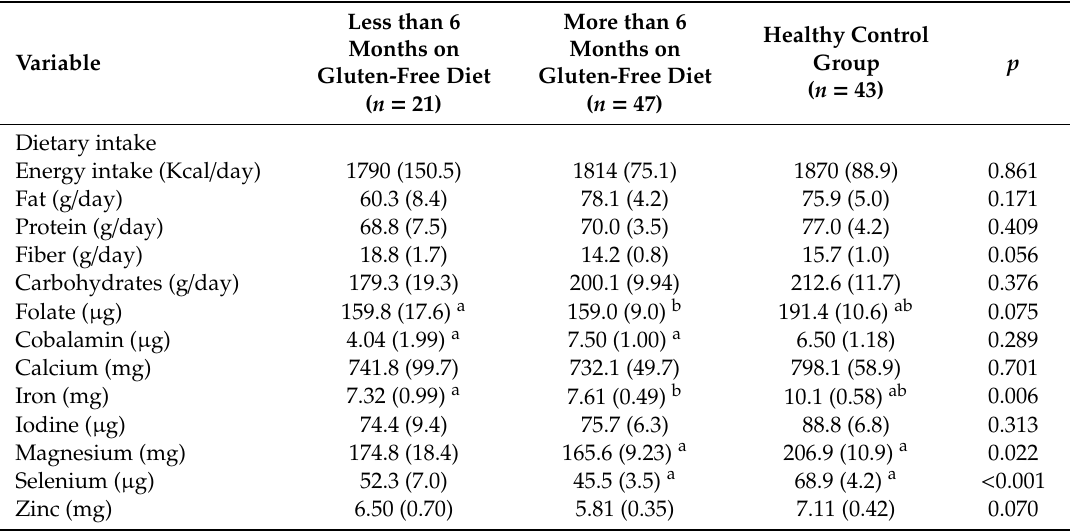
Table 3. Di ff erences between healthy control children, patients with a gluten-free diet in the last 6 months and patients with a gluten-free diet less than 6 months on dietary intake